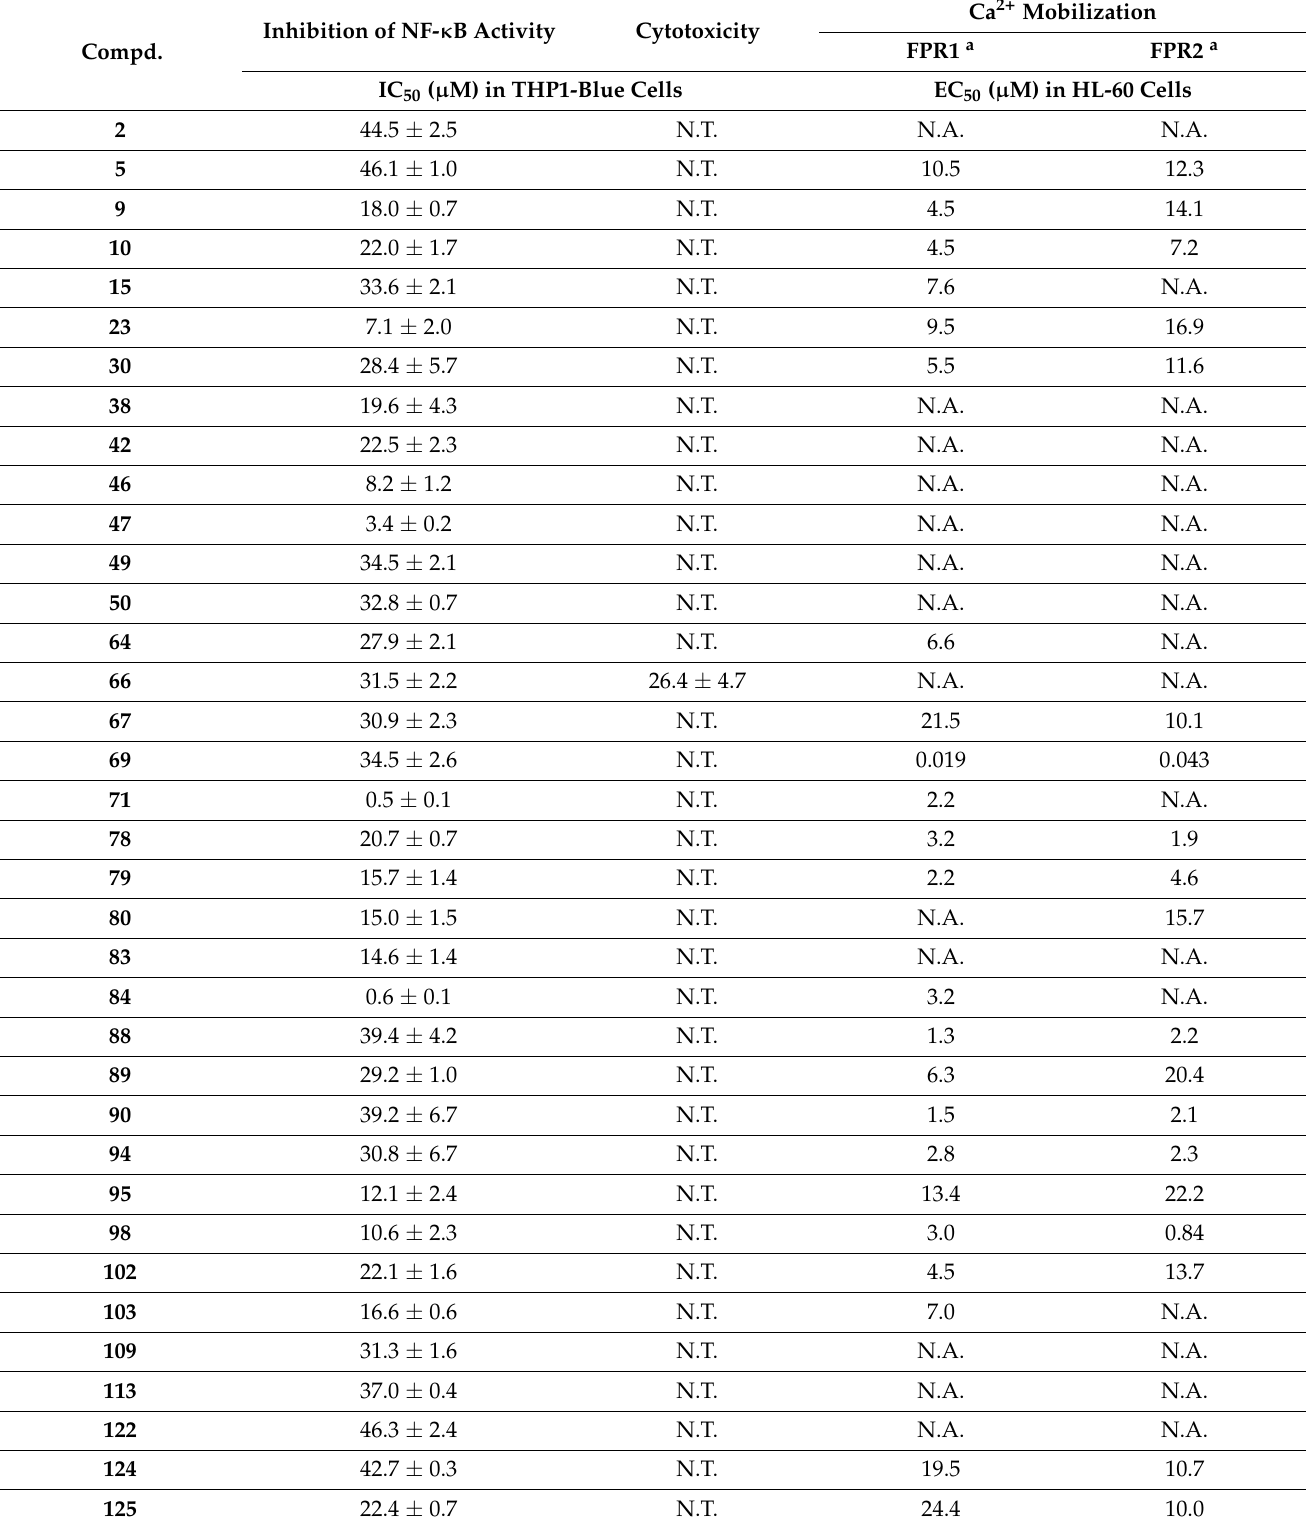
Table 2. The effects of the test compounds and FPR peptide agonists on the LPS-induced NF- κ B activity in human THP1-Blue cells, cytotoxicity, and Ca 2+ mobilization in FPR1/FPR2-transfected HL-60